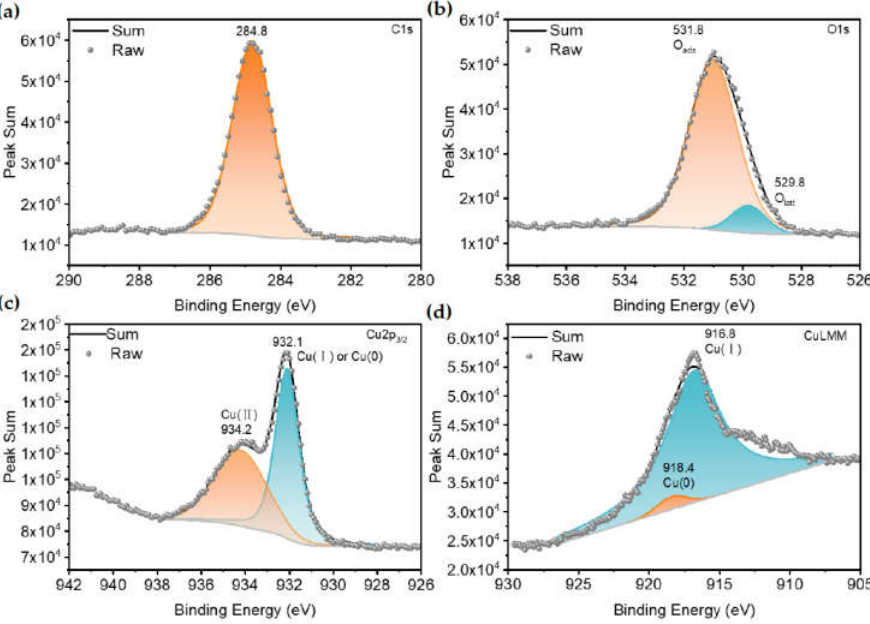
Figure 5. XPS spectra of CuNWs for ( a ) C1s, ( b ) O1s, ( c ) Cu2p 3/2 and ( d )